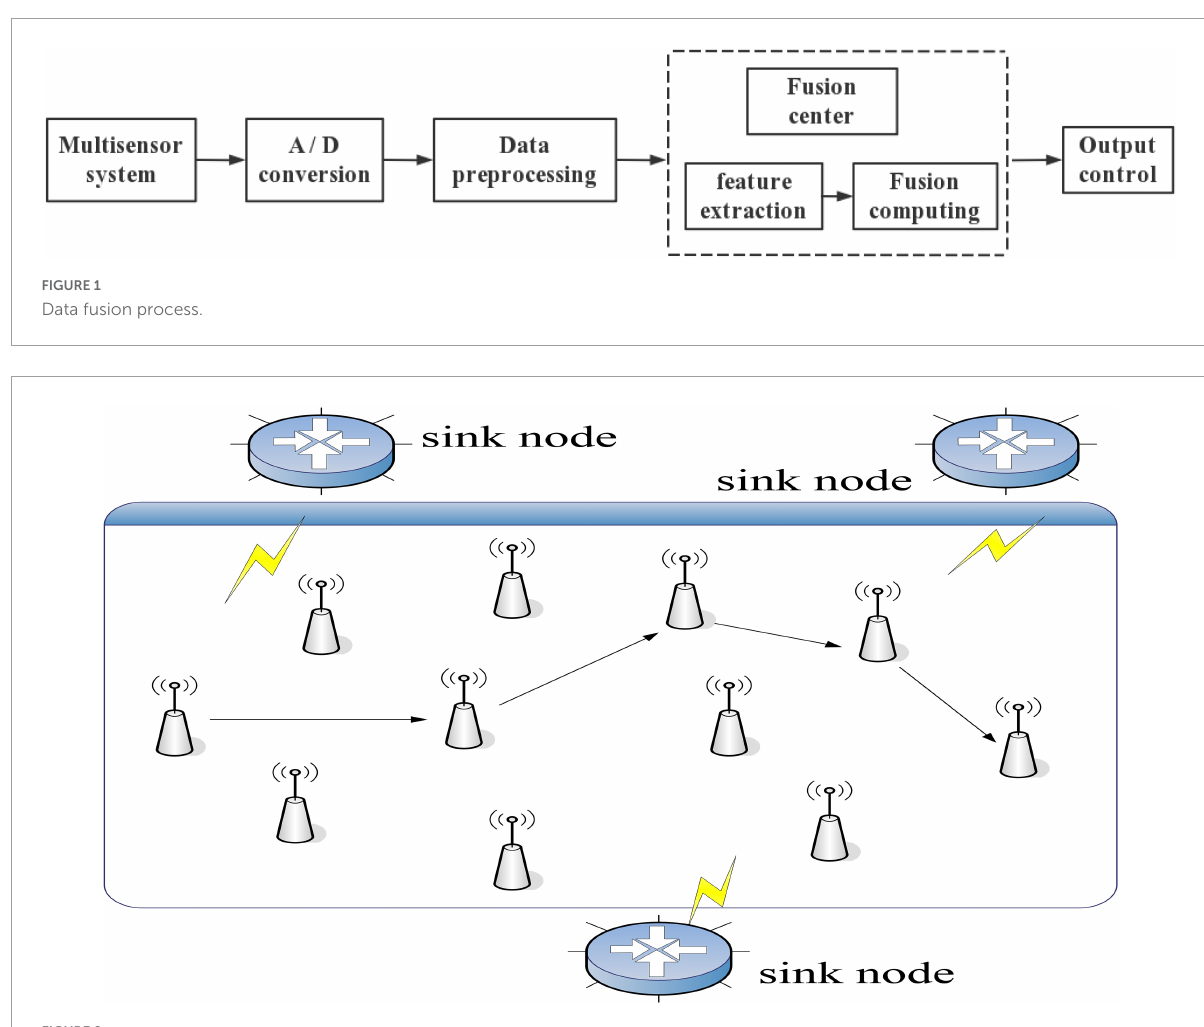
FIGURE2 Schematic diagram of data aggregation